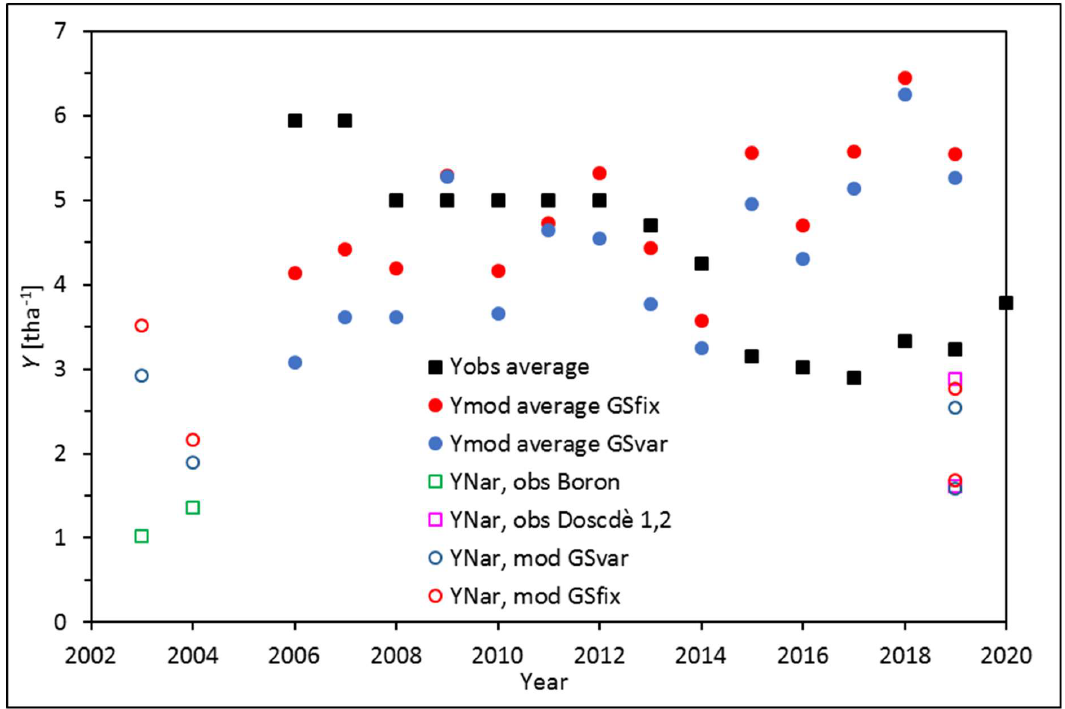
Figure 3. Simulated and observed annual pasture yields during 2003–2019: results of the simulations (red dots: fixed growing season; blue dots: variable growing season) are shown along with observed ISTAT data (full black squares) covering the whole Sondrio province. We report in situ data of biomass of Nardus stricta in Alpe Boron (2003–2004) (empty green squares) and Alpe Dosdè (2019, 2 sites) (empty pink squares), and the estimates from the simulation (empty red/blue circles) in the corresponding cells of the 1 × 1 km 2 grid (see Figure 1 and Section 3.2).